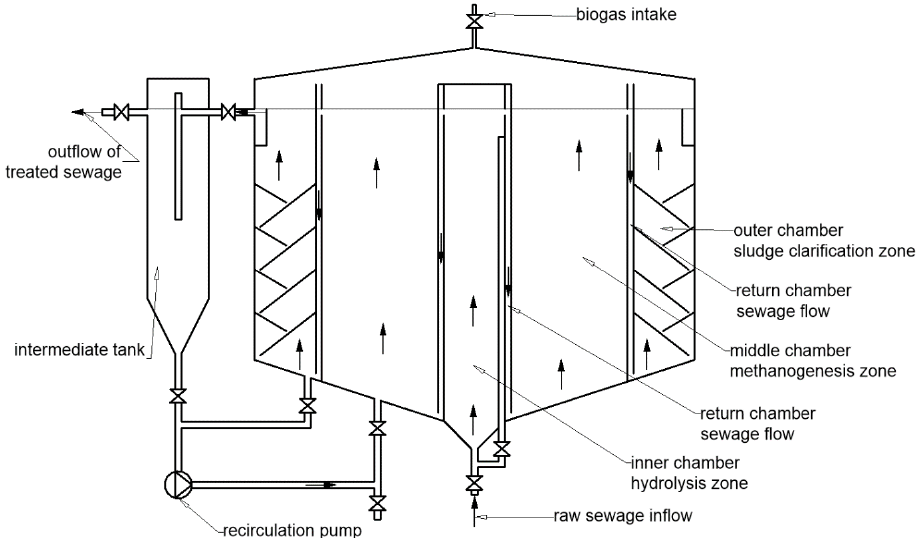
Figure 1. Scheme of anaerobic labyrinth-flow